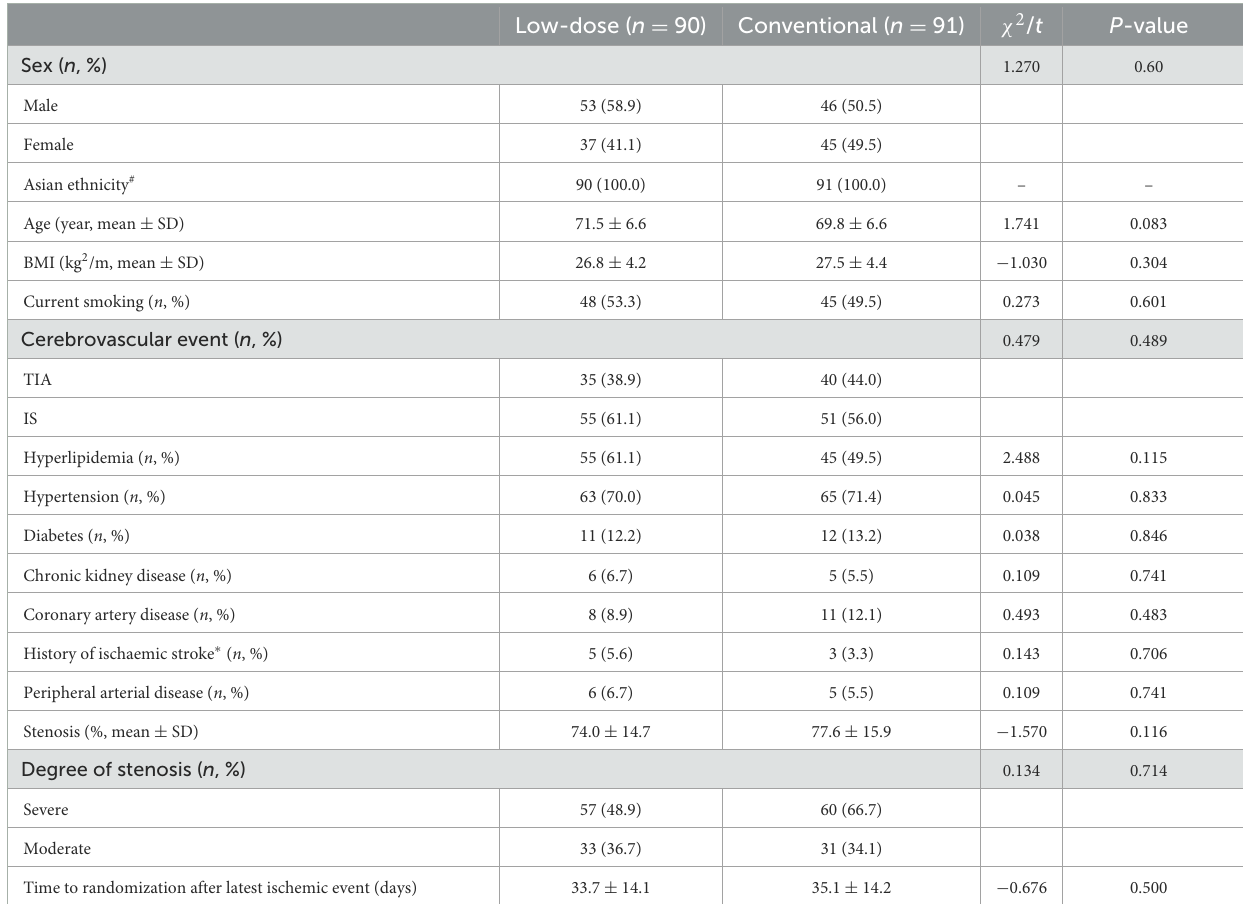
TABLE 2 Baseline characteristics of study participants ( n ,